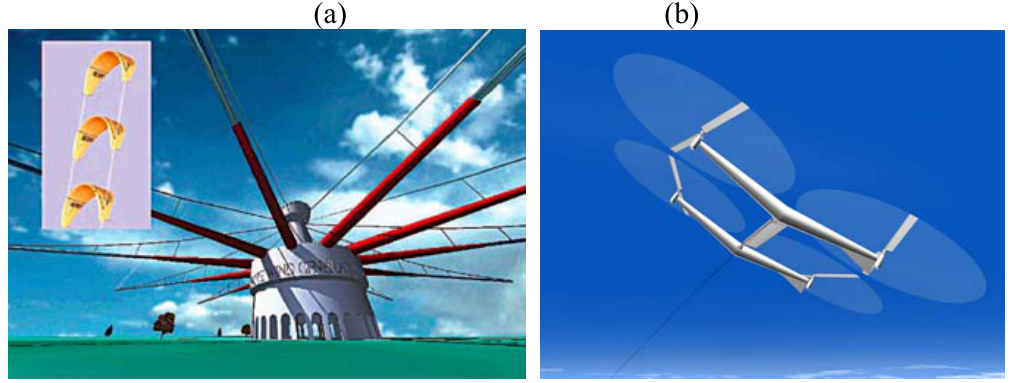
Figure 1. Examples of high-altitude technologies: (a) KiteGen, kites aimed at altitudes of 1000 m and tethered to a spinning carousel at the ground; and (b) Flying Electric Generators by Sky Windpower, tethered rotorcrafts aimed at altitudes of 10,000 m (picture courtesy of Ben